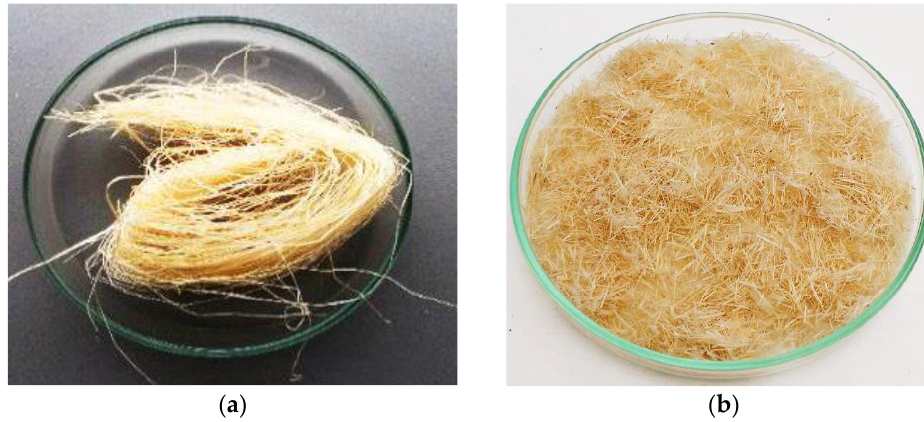
Figure 1. ( a ) Curauá long fibers before treatment and ( b ) fibers cut and treated with 5% NaOH.